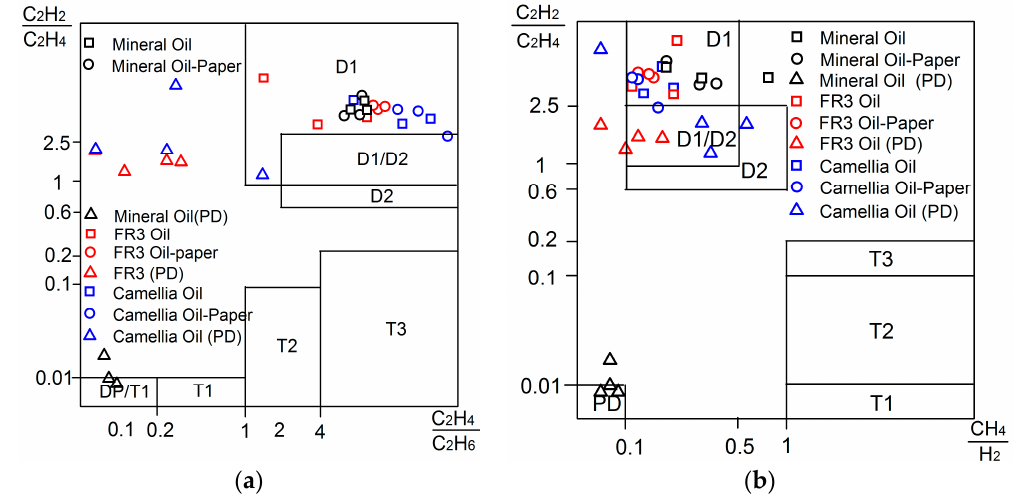
Figure 15. Diagnostic results of simulated electrical faults using graph representation method: ( a ) According to the ratio of C 2 H 2 /C 2 H 4 and C 2 H 4 /C 2 H 6 ; ( b ) According to the ratio of C 2 H 2 /C 2 H 4 and CH 4 /H 2 .